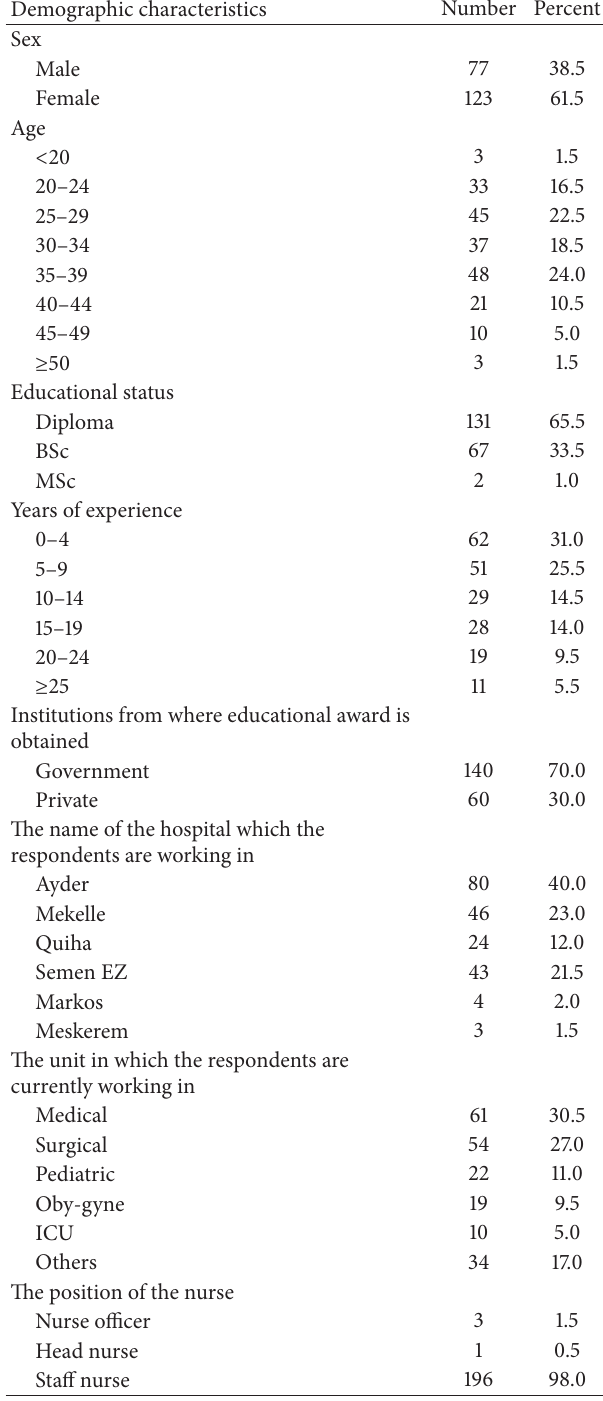
Table 1: The frequency distribution according to the respondents by their demographic characteristics in Mekelle Zone Hospitals, northern Ethiopia, March 2011 ( 𝑛 = 200